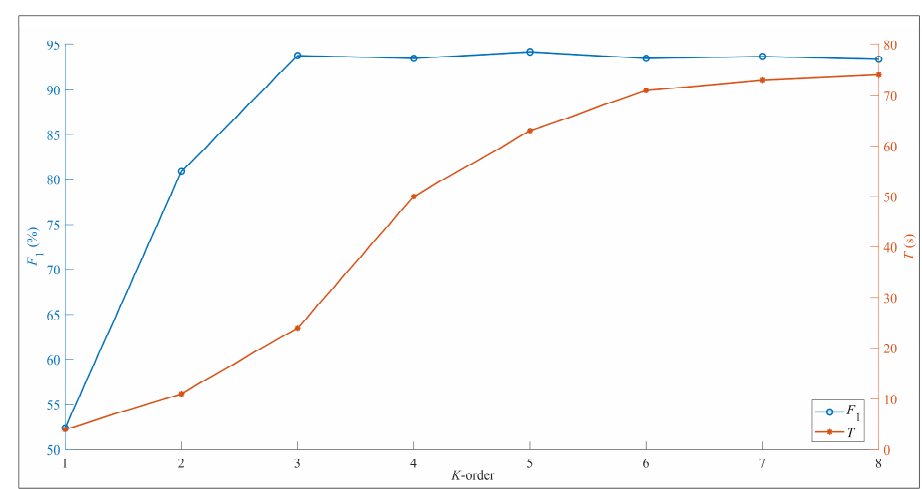
Figure 8. Statistical results of different K values.